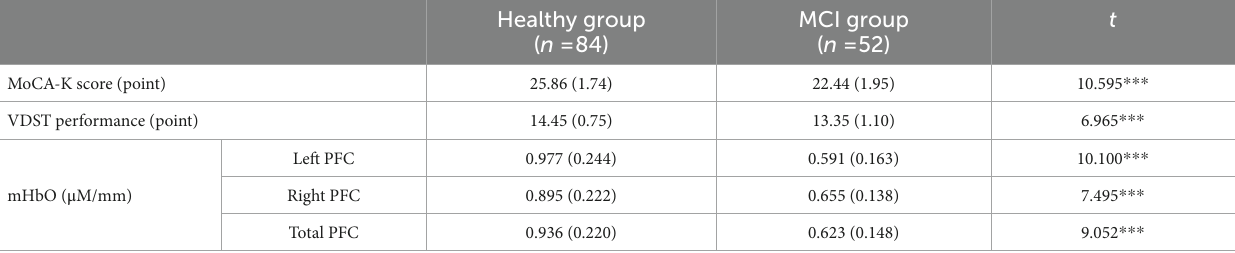
TABLE 2 Behavioral performance and fNIRS analysis ( N =